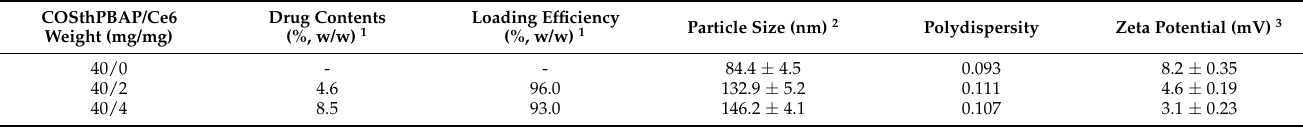
Table 1. Characterization of COSthPBAP nanophotosensitizers.